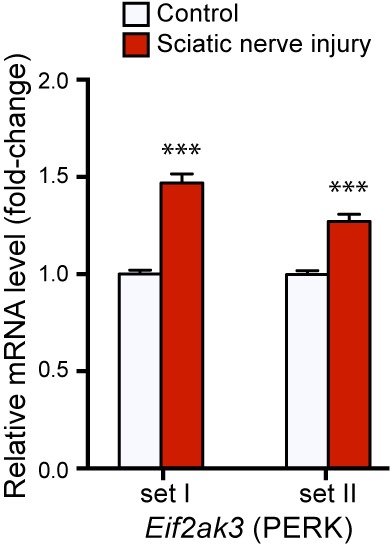
qRT-PCR validation of Perk mRNA upregulation in L4 DRG 24 h after SNC using two different primer sets (n = 4 per condition).